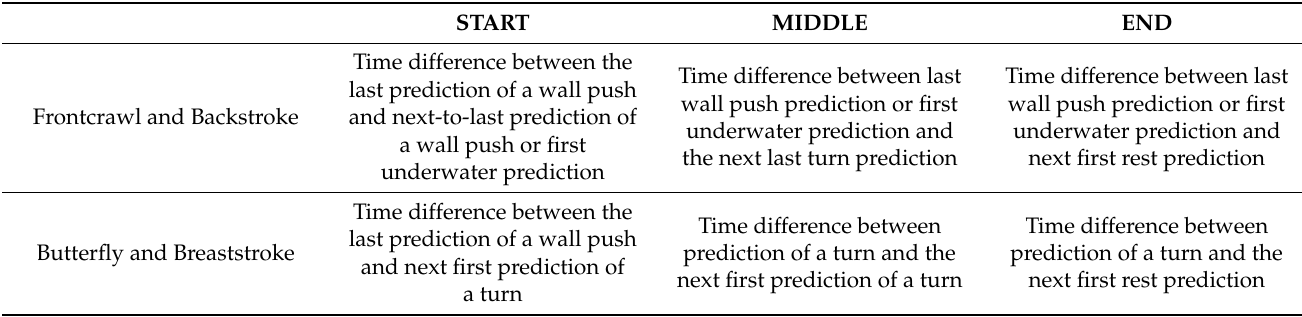
Table 4. Definition of phases and events to compute IMU lap